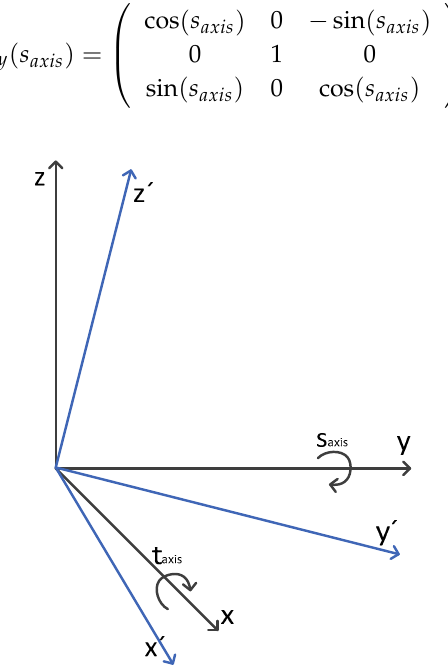
Figure 2. Skew of the rotation axis of the radar.